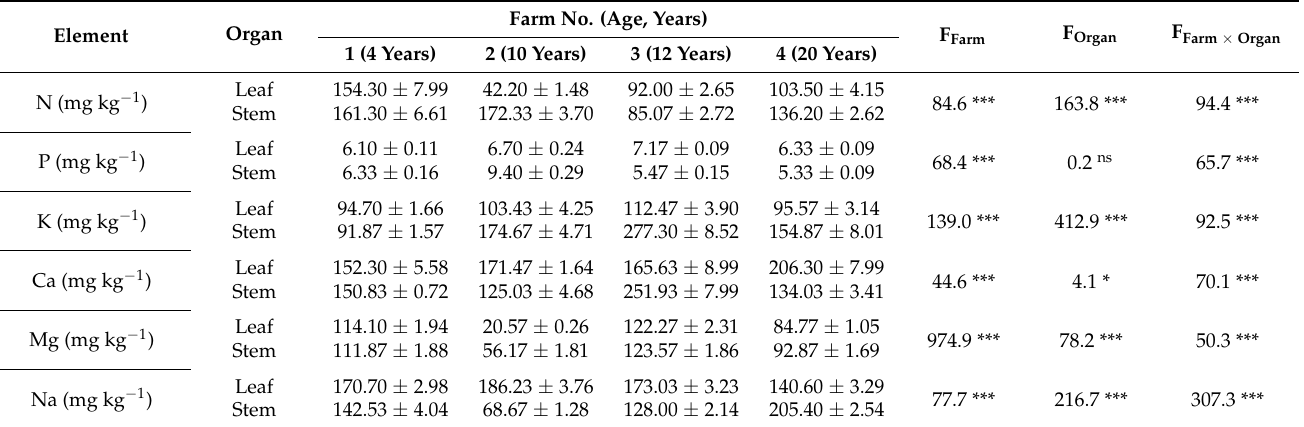
Table 3. Mean ( ± standard error, n = 6) inorganic nutrient contents of Taif Rose populations grown in four farms in the mountainous area of Taif City in Saudi Arabia.